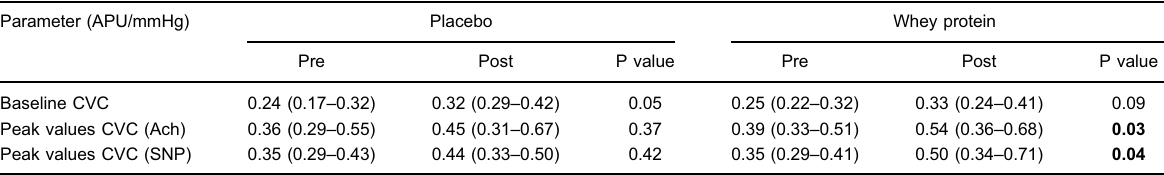
Table 2. Effects of 12-week dietary supplementation with placebo or whey protein on systemic microvascular fl ow and reactivity of patients with chronic heart failure. Parameter (APU/mmHg) Placebo Whey protein